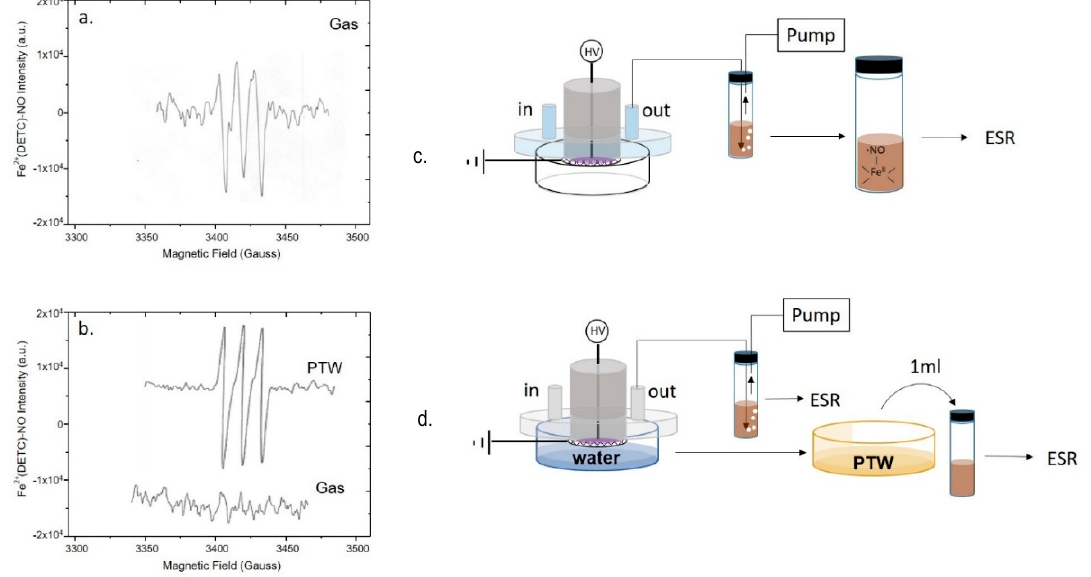
Figure 3. Production of • NO in the plasma phase or in the liquid underneath. EPR spectra of mononitrosyl-iron complex MNIC acquired by ( a , c ) bubbling the plasma effluent in the spin trap solution during a DBD with no liquid present, or by ( b , d ) simultaneous sampling the plasma effluent and the PTW. Experimental DBD conditions: 15 min, 0.5 (SLM) Air, 13 kV, 6 kHz, 50% DC, 100 ms period. The experimental schemes used for EPR detection are reported on the right of each spectrum.